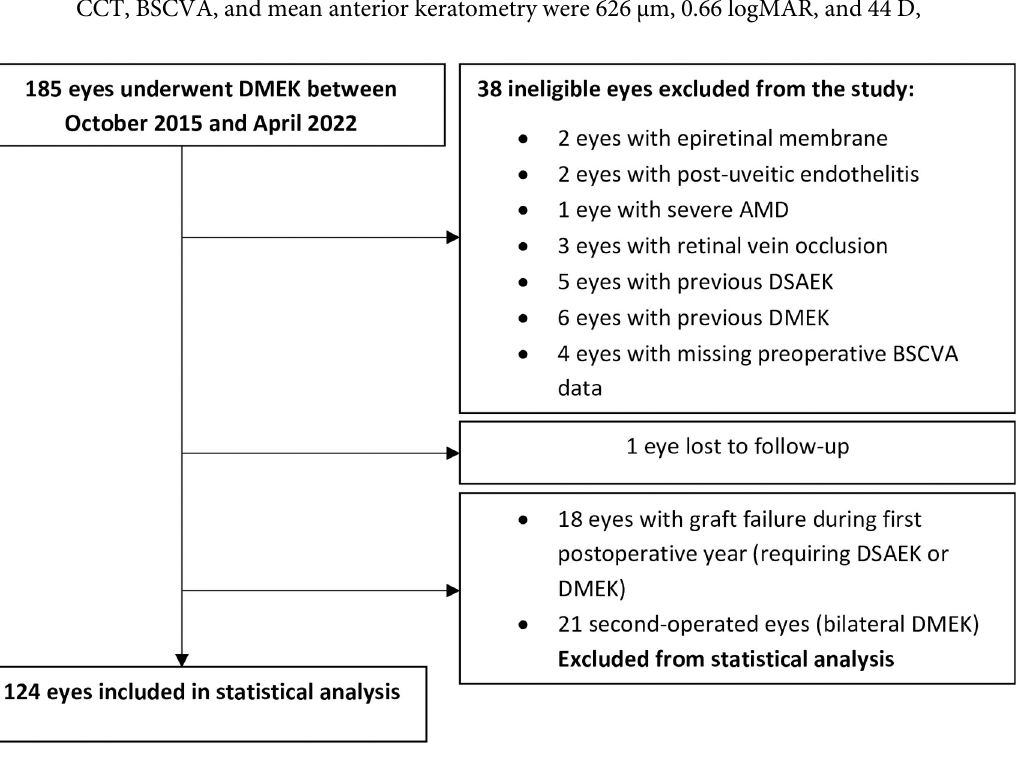
PLOS ONE | https://doi.org/10.1371/journal.pone.0282594 March 3,